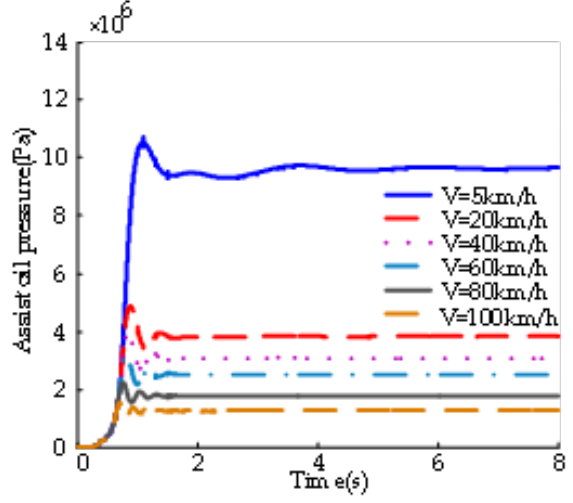
Figure 18. Graph of assist oil pressure at different speeds.